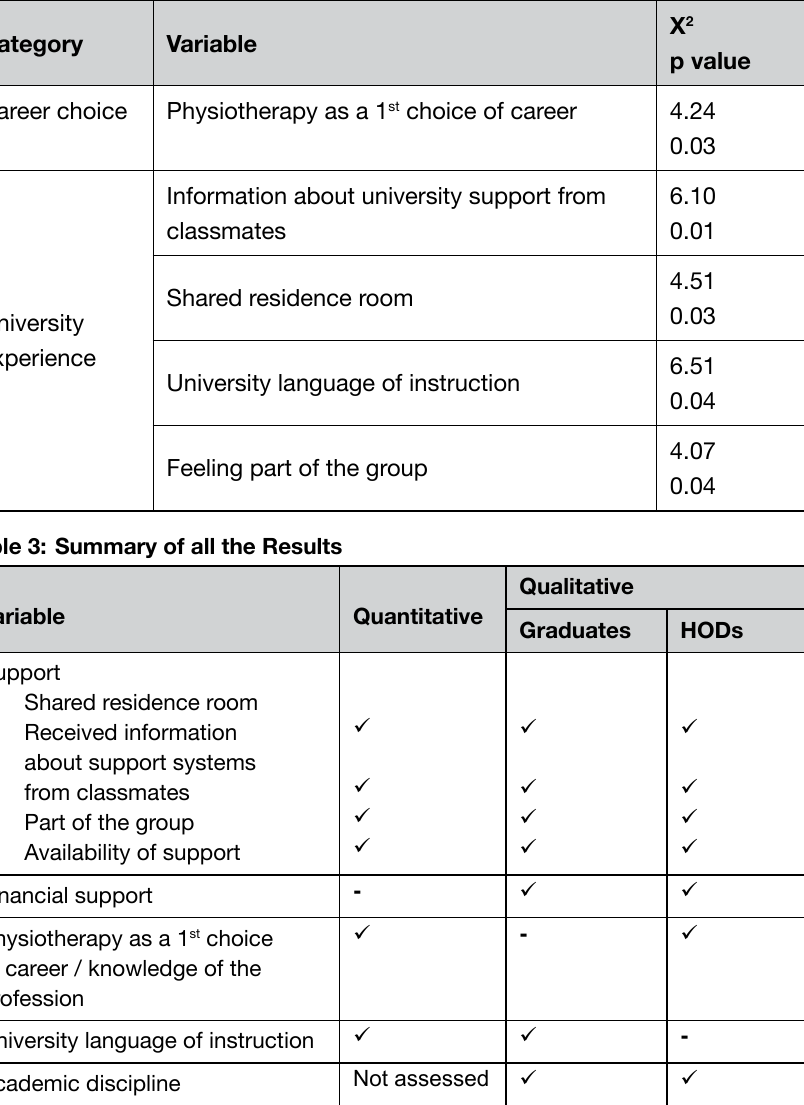
Table 2: Summary of Significant Variables for Black Respondents category